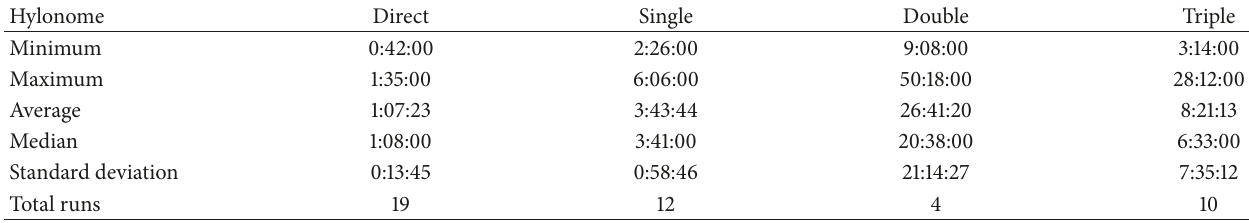
Table 3: Convergence times for various simulation types for trajectories to Hylonome.